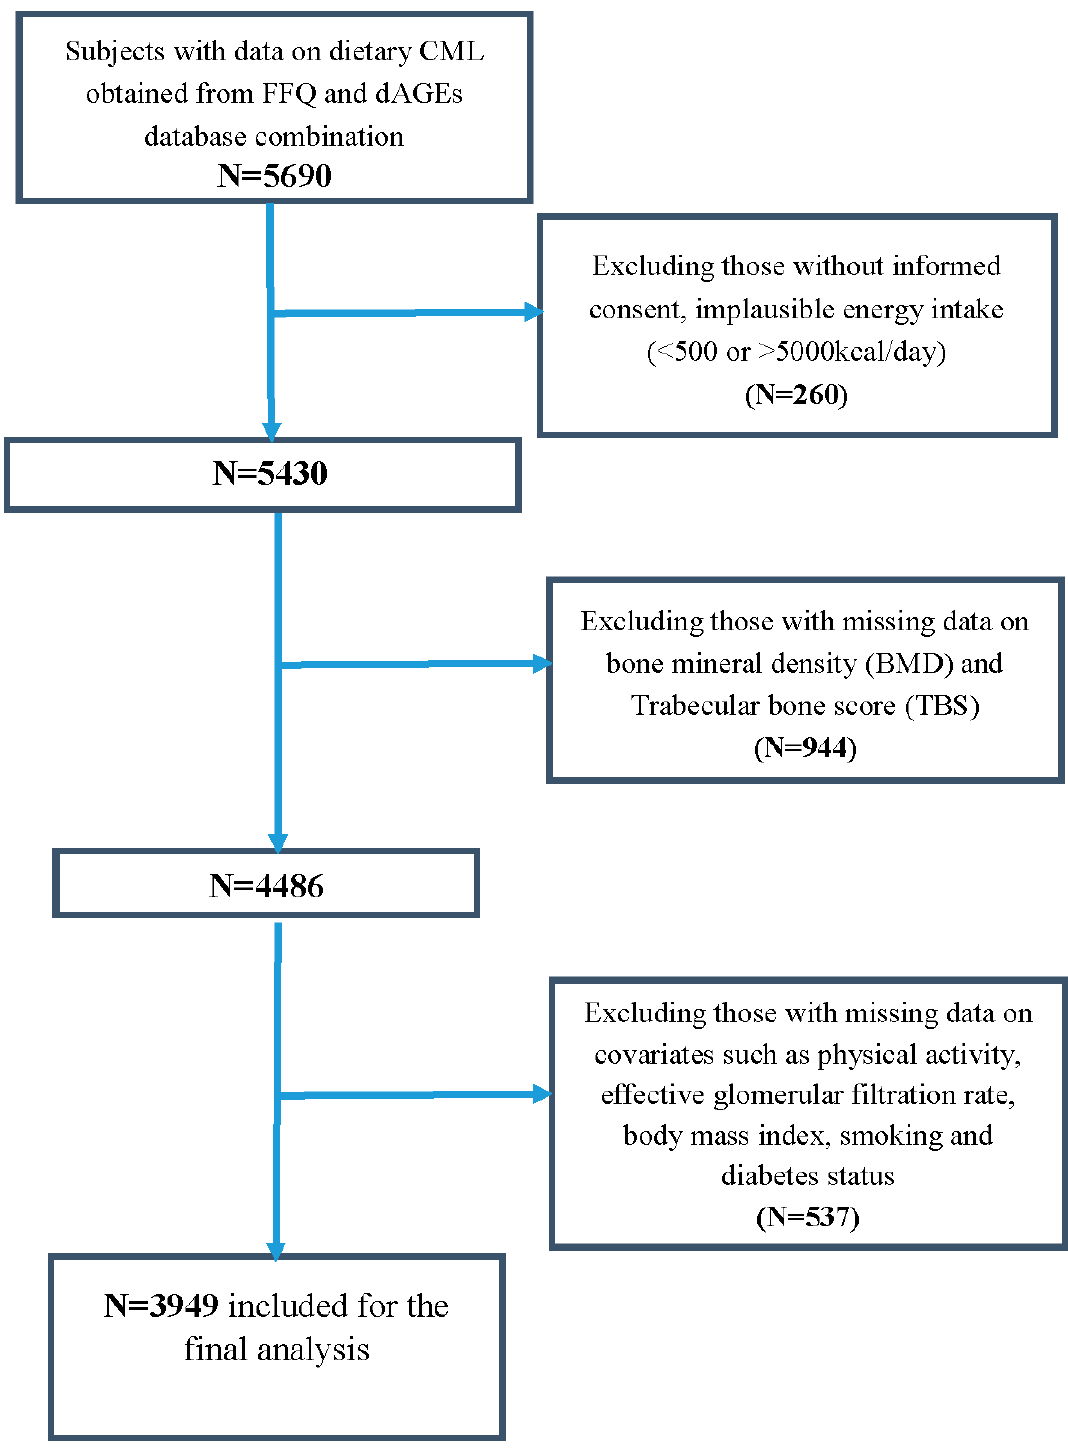
Figure 1. Flowchart of participant inclusion from the Rotterdam Study. CML, Carboxymethyllysine; FFQ, food frequency questionnaire; dAGEs, dietary advanced glycation end-products.